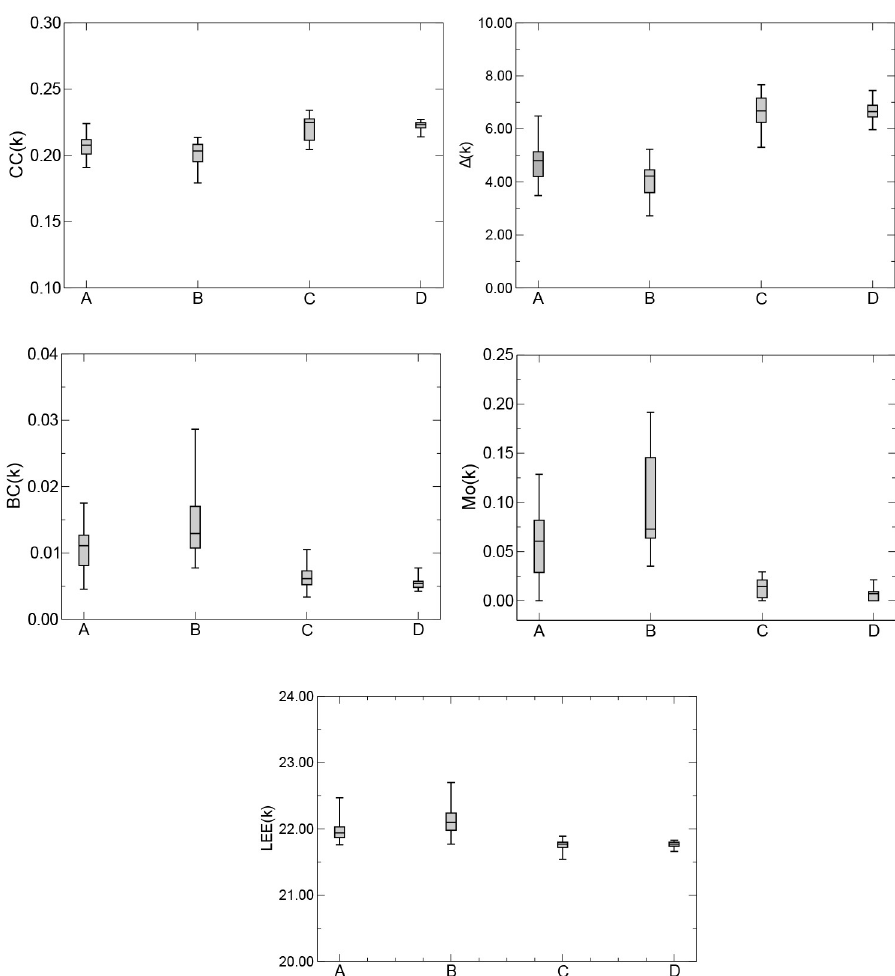
Fig 4. Boxplots of CC ( k ), Δ ( k ), BC ( k ), Mo ( k ),and LEE ( k ) for k max = 9, k max = 10, k max = 6, k max = 6, and k max = 8, respectively, for the groups A, B, C, and D. Boxplots from patients with different health states show different means (placed at the center of each box), which are 0.2077, 0.2033, 0.2248, and 0.2232 for CC ( k ); 4.8010, 4.2190, 6.6790, and 6.6510 for Δ ( k ); 0.0111, 0.0129, 0.0061, and 0.0054 for BC ( k ); 0.0605, 0.0728, 0.0145, and 0.0072 for Mo ( k ); and